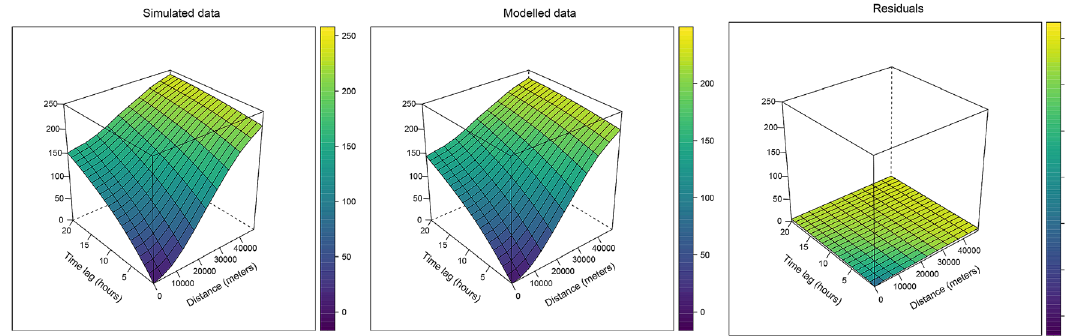
Figure 4. Variography for the simulated dataset model. Spatio-temporal semivariograms have been computed on the test points for the simulated data (left), the model implemented using the first 20 EOFs components (center) and its residuals